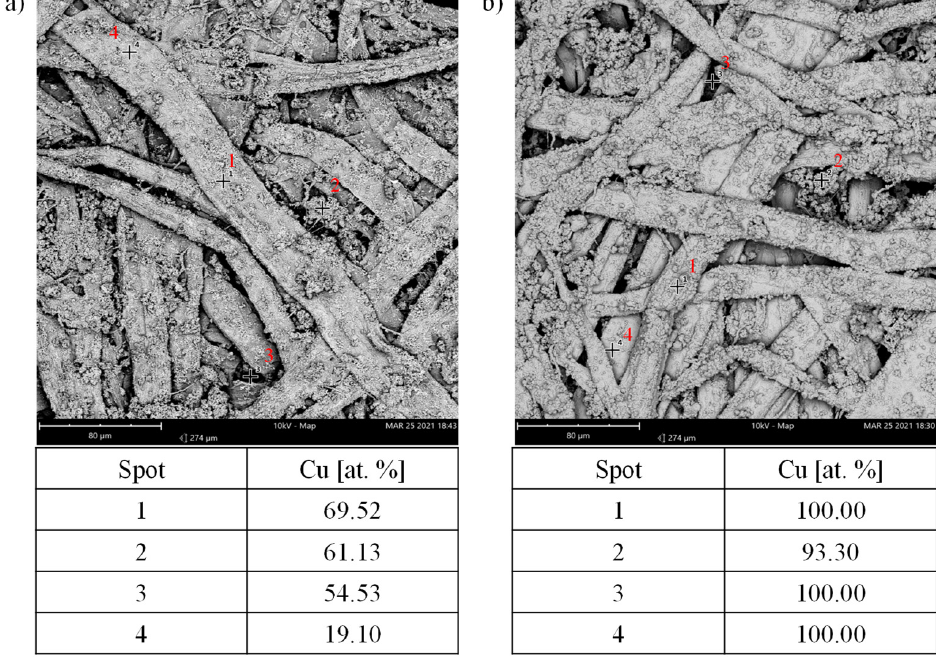
Figure 7. EDS surface point analysis of the ( a ) PCu2_5 and ( b ) PCu10 samples.